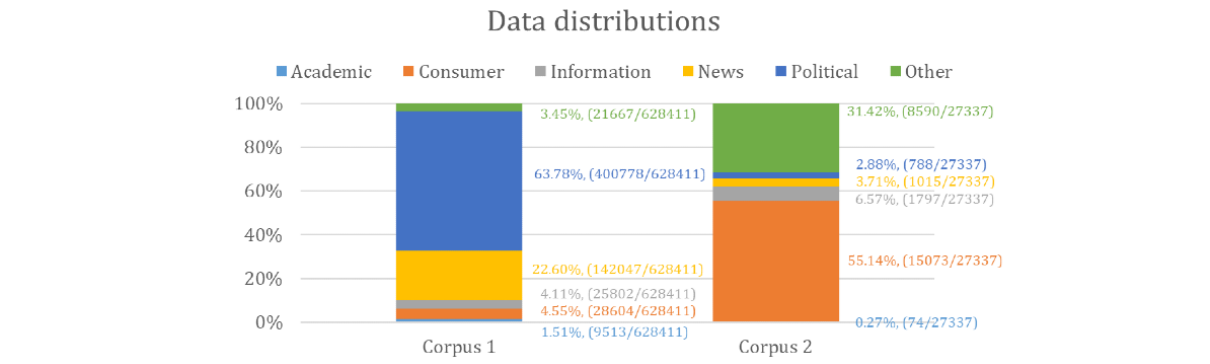
Figure 3. Postclassification class distributions among 2 corpora, as per the automatically classified